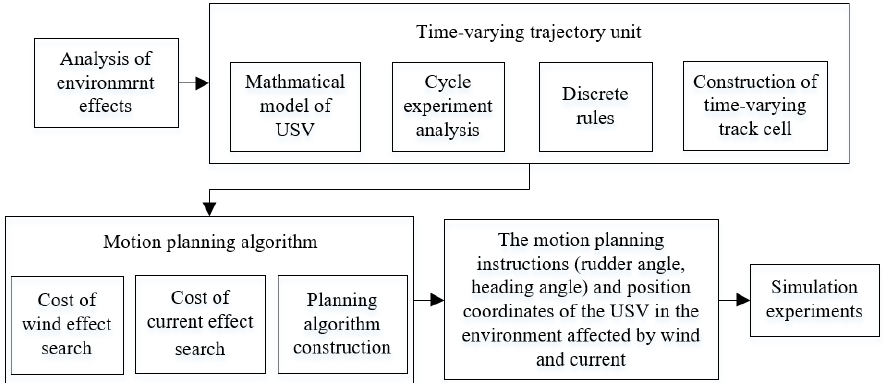
Figure 2. Structure of the motion planning method for USVs based on the regularization- trajectory